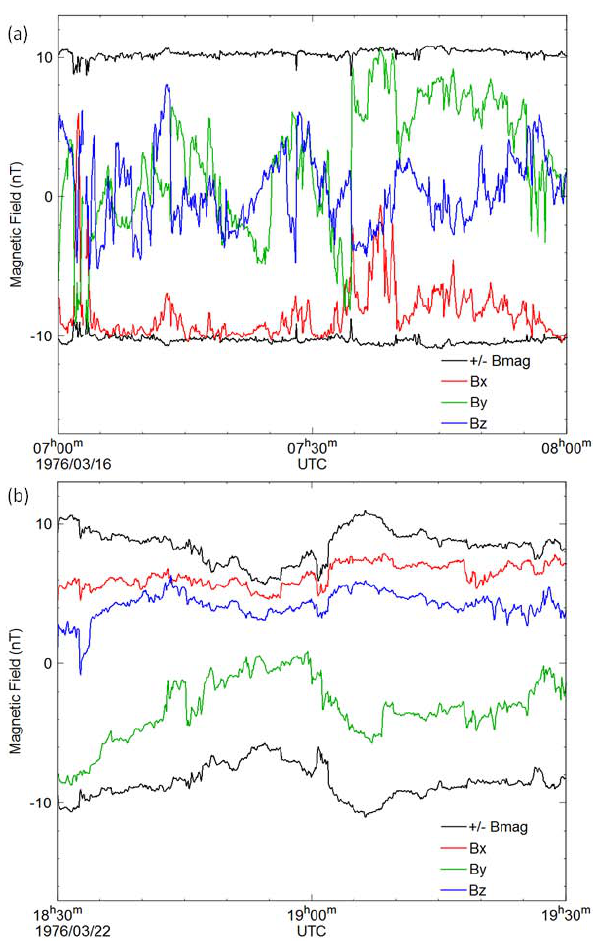
Fig. 2. (a) An example of an hour of incompressive rotation in the solar wind (Helios 2). The black line, which remains relatively con- stant at 10nT, is the magnetic field magnitude and its negative. The components fluctuate strongly, indicating the presence of significant rotations. (b) An example of an hour of magnetic field variations that are naturally contaminated by compressions (Helios 2). Here the component variations are correlated with changes in the field magnitude, indicating strong compressional